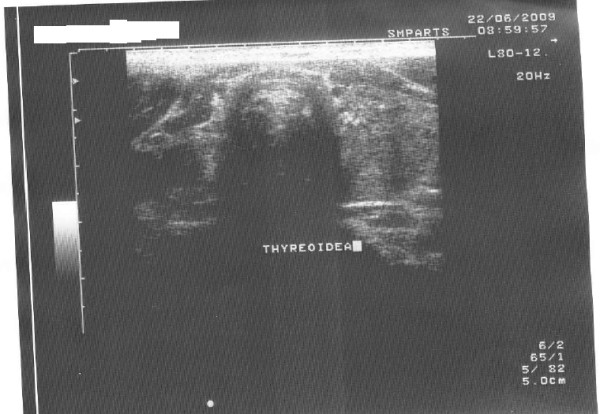
Neck ultrasound.